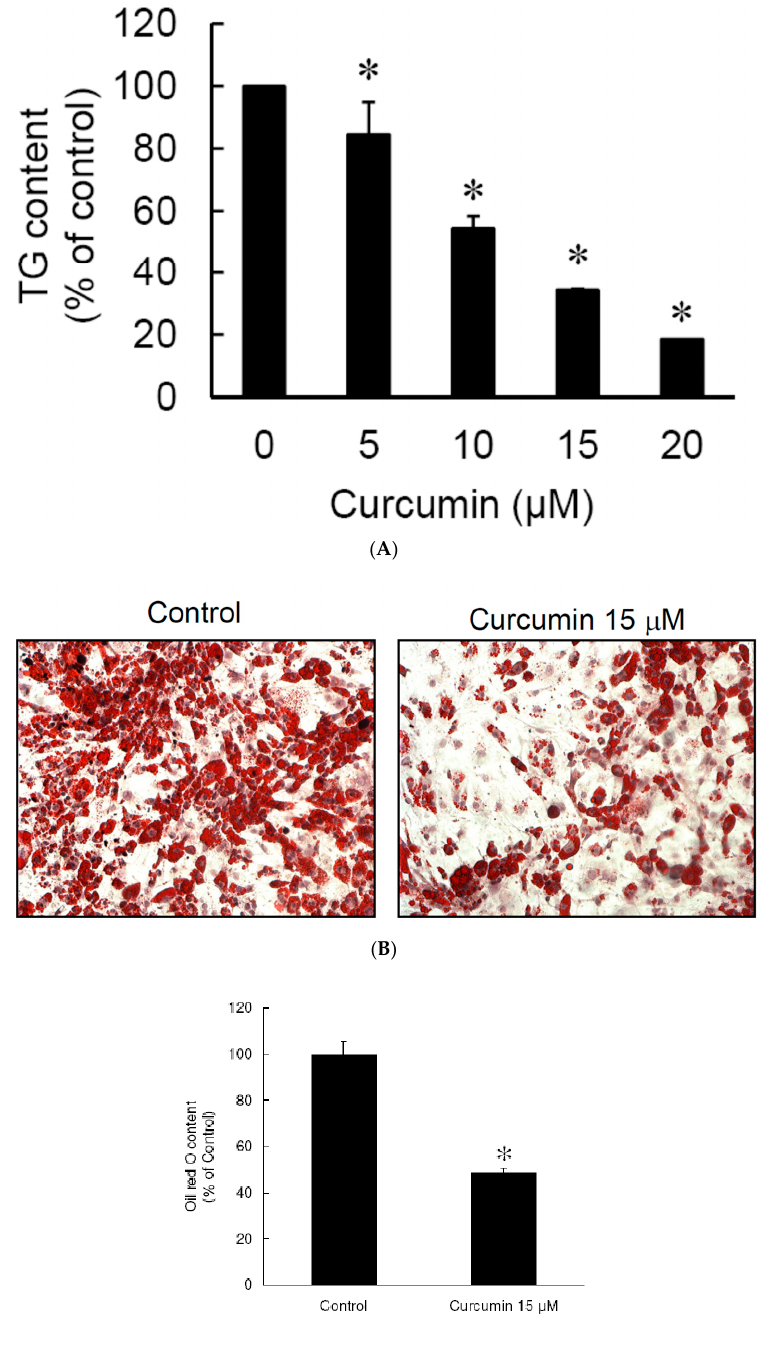
Figure 3. Low dose curcumin inhibits adipogenesis in 3T3-L1 adipocytes. 3T3-L1 preadipocytes were pretreated for 1 h with di ff erent concentrations of curcumin (0, 5, 10, 15, 20 µ M) ( A ) or with 15 µ M curcumin ( B , C ), then adipocyte di ff erentiation was induced in the continued presence of the same concentration of curcumin. At the end of di ff erentiation, the intracellular lipid content was determined by measuring triglyceride (TG) ( A ) and Oil red O staining (B , C ). In ( A , C ), the results are the mean ± SD for four independent experiments. * P < 0.05 compared to the vehicle control. The results shown in ( B ) are representative of those in four separate